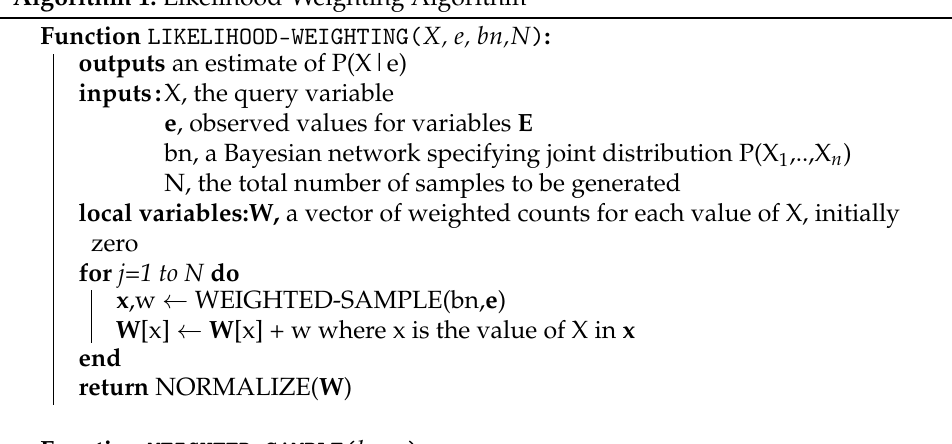
Algorithm 1: Likelihood-Weighting